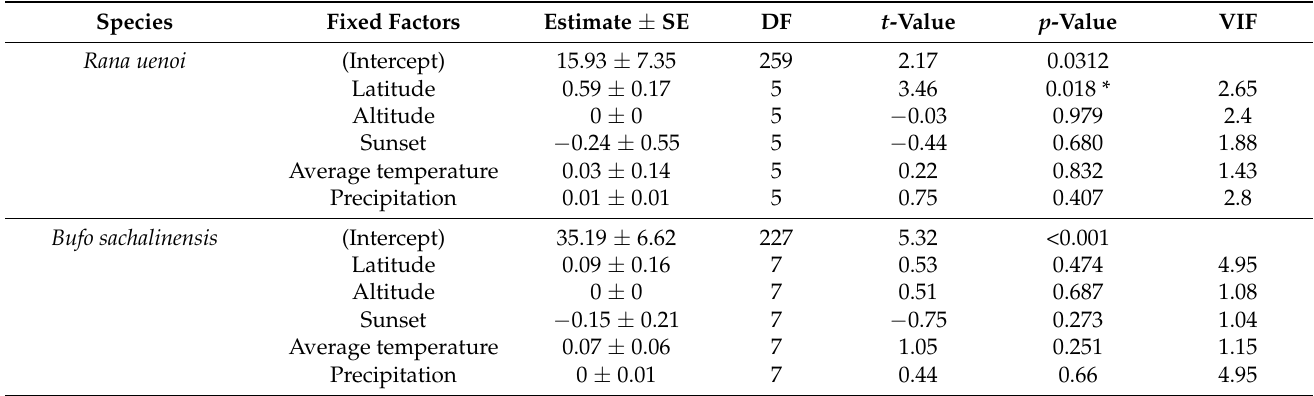
Table 2. Summary of linear mixed effect models for the CTmax of tadpoles. For Rana uenoi , we tested a total of 270 tadpoles from 11 localities (random factor), with marginal R 2 /conditional R 2 = 0.59/0.80. For Bufo sachalinensis , we used a total of 240 observations from 10 localities (random factor), with marginal R 2 /conditional R 2 = 0.09/0.50. CI = confidence interval; VIF = variance inflation faction; significant results are labeled with